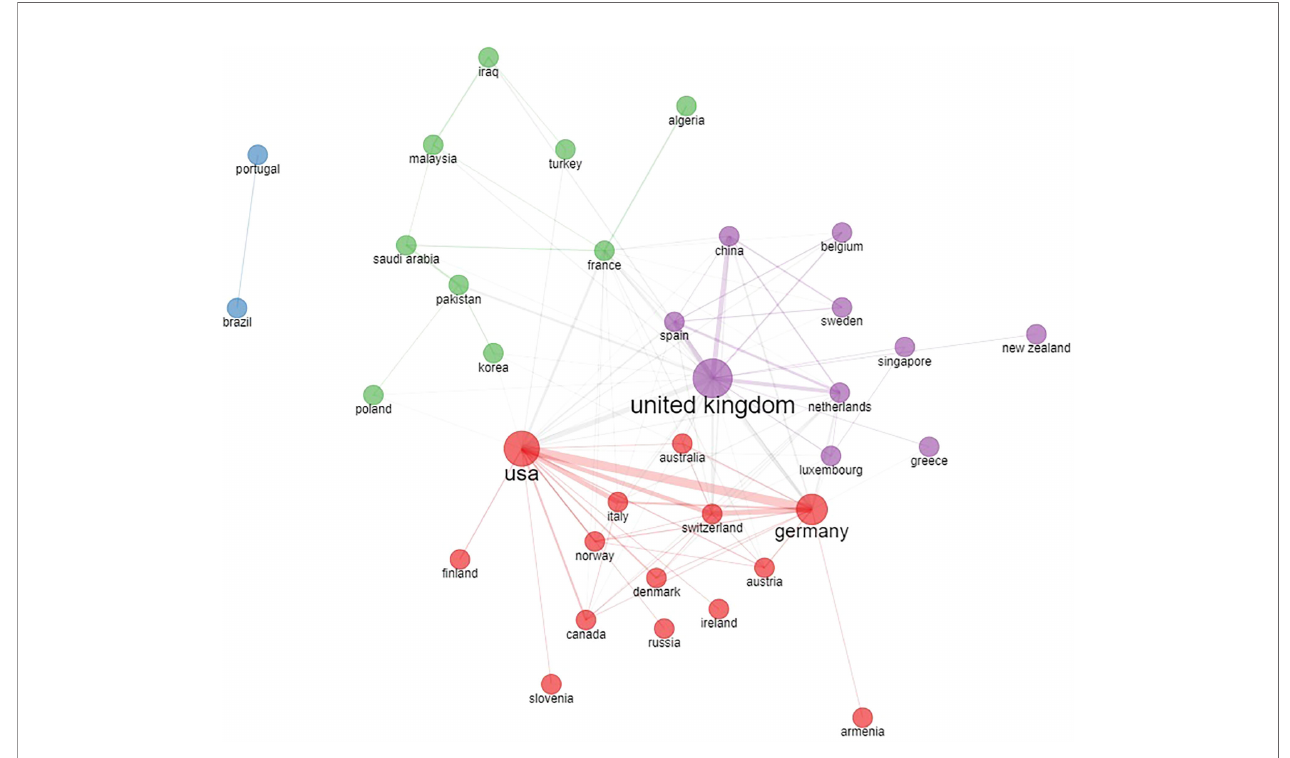
FIGURE 3 | Country collaboration network based on country of authors in the original papers included in the bibliometric analysis.